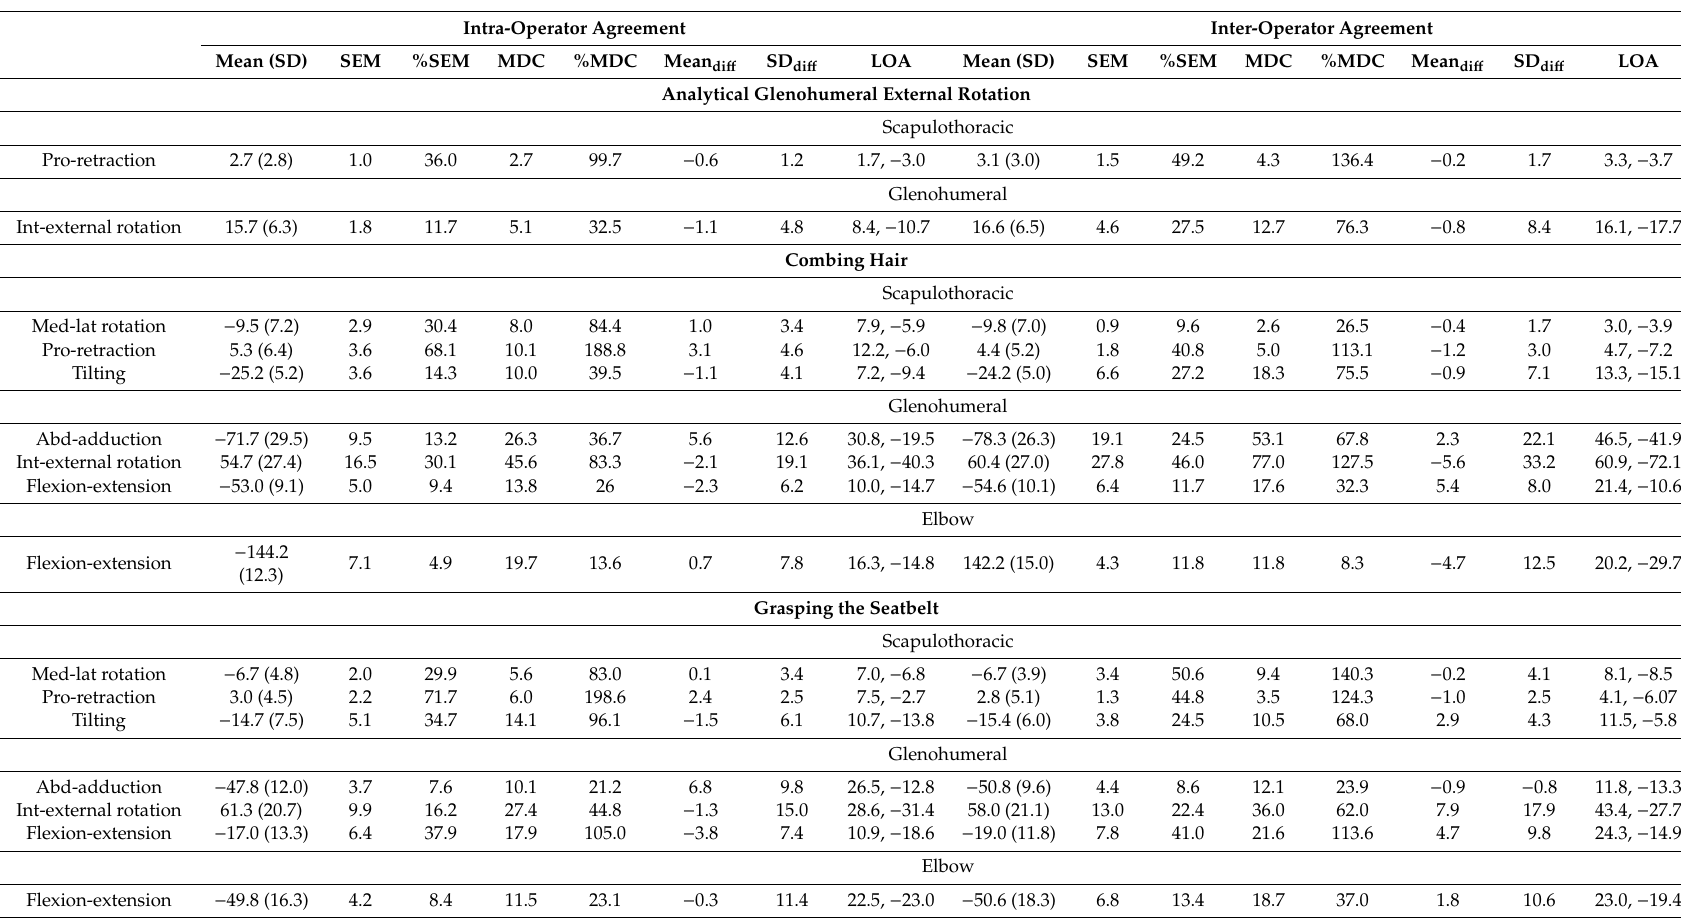
Table 3. Intra-operator and inter-operator means, standard deviations, standard error of measurements, minimal detectable changes and 95% limits of agreement expressed in degrees, for the di ff erent